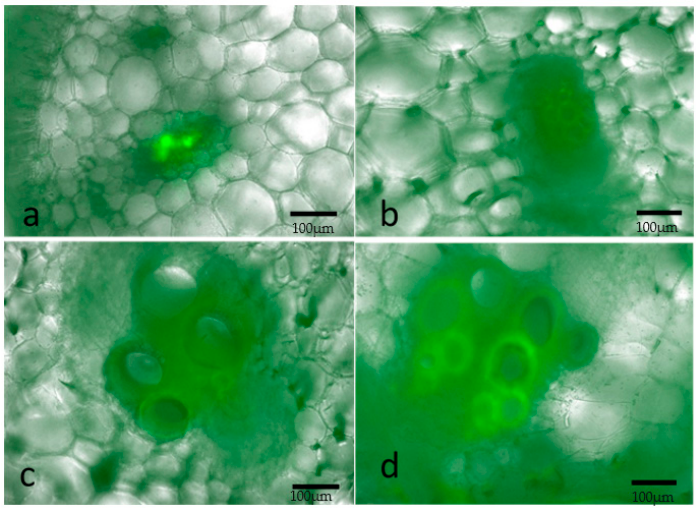
Figure 3. Localization of GFP-labeled bacteria in susceptible line PI 218071 9dpi. Cross-section micrographs of overlay of bright field and GFP fluorescence signal showing GFP-labeled bacteria concentrated in vascular system. ( a ): inoculated leaf petiole, ( b ): topmost leaf petiole at 12 cm above the inoculated leaf, ( c ): stem at 5 cm above the inoculated leaf and ( d ): stem 8 cm below the inoculated leaf. The presence of bacteria is indicated by the fluorescence. Scale bars = 100 µm.